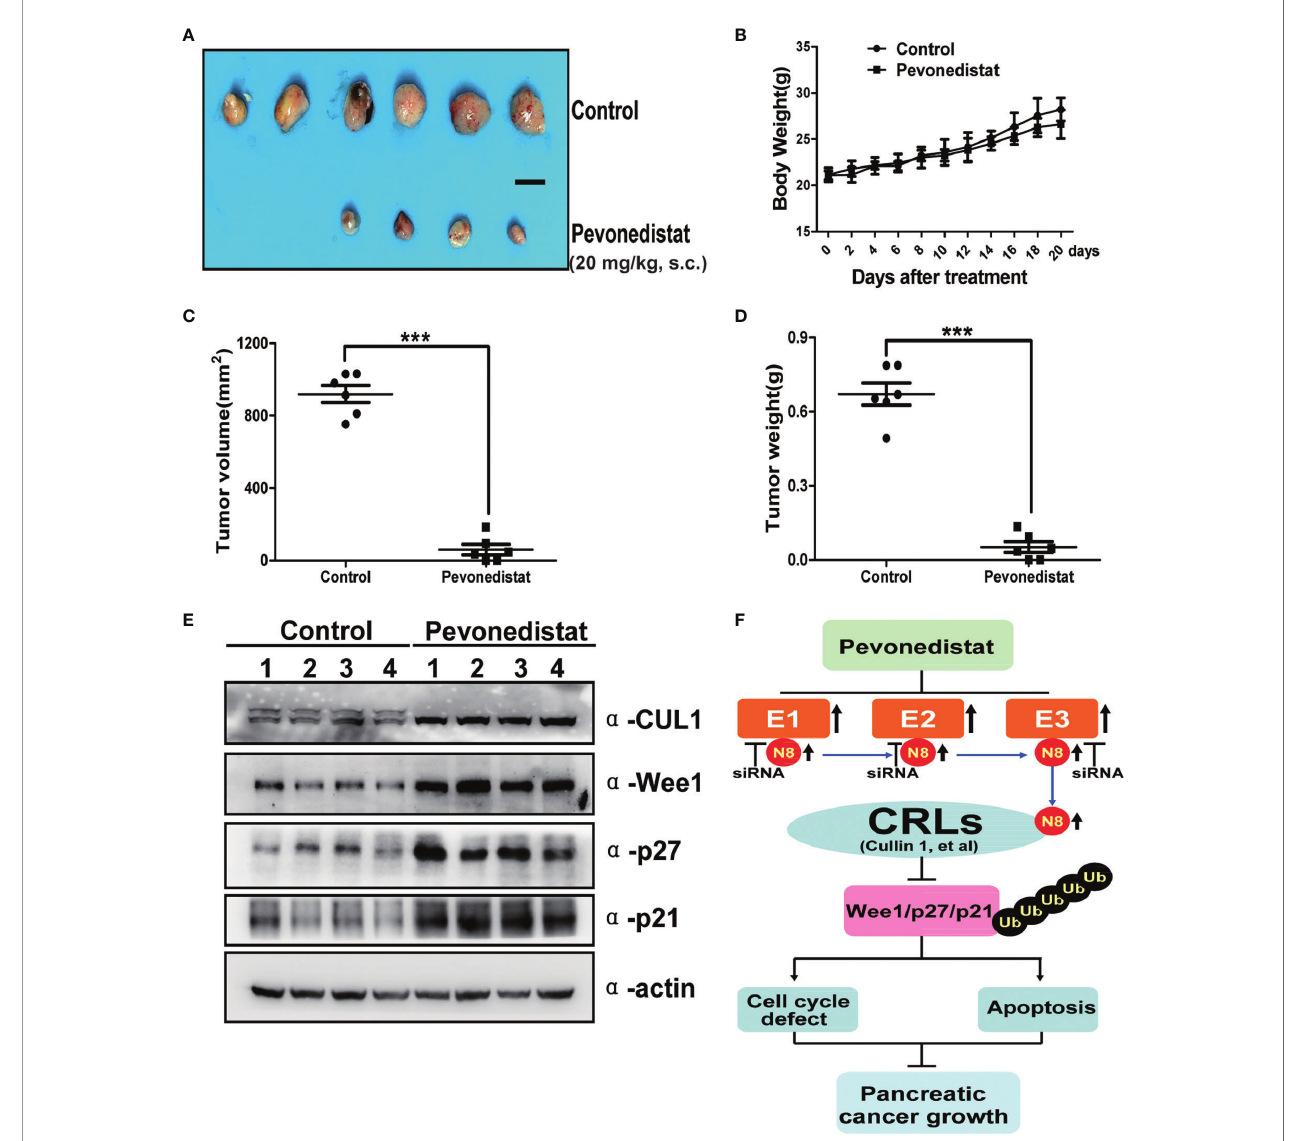
FIGURE 6 | Pevonedistat suppressed the growth of pancreatic cancer in vivo . (A – E) Capan-1 cells measuring 1 × 10 7 were injected subcutaneously and subjected to tumor growth analysis. Mice were sacri fi ced at the end of pevonedistat (20 mg/kg, s.c.) vs. control treatment (n = 6). (A) Tumor tissues of mice were collected and photographed (scale bar = 1cm). (B) Mice were weighed during pevonedistat vs. control treatment schedule. (C) Tumor size was determined by caliper measurement (***p<0.05). (D) Tumor was weighed on the sacri fi ced day (***p < 0.05). (E) Proteins extracted from tumor tissues and subjected to immunoblotting analysis against Cullin 1, Wee1, p27, and p21 with actin as a loading control. Data represent means, and error bars are SD. Two-sided t-test. (F) A working model of pevonedistat targeting neddylation pathway in pancreatic cancer. N8, NEDD8; CRLs, Cullin-RING E3 ubiquitin